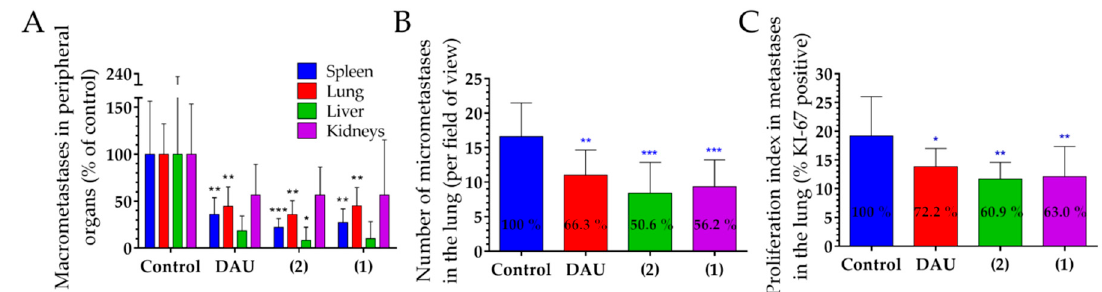
Figure 5. Effect of GnRH-III-Dau conjugates 1 and 2 (10 mg/kg Dau content, 6 treatments) and free Dau (1 mg/kg, 3 treatments) in orthotopic 4T1 mice breast carcinoma bearing mice. ( A ) Number of macro-metastases in peripheral organs (average % of control ± SD). ( B ) Effect of GnRH-III-Dau conjugates on the number of micro-metastases in lung (average number ± SD). ( C ) Proliferation of metastases in lung (average proliferation index ± SD). Statistical analysis was performed by Mann–Whitney test. *, ** and *** mean significant at p < 0.05, p < 0.01 and p < 0.001, respectively. * blue mean significant difference compared to control group (B,C).